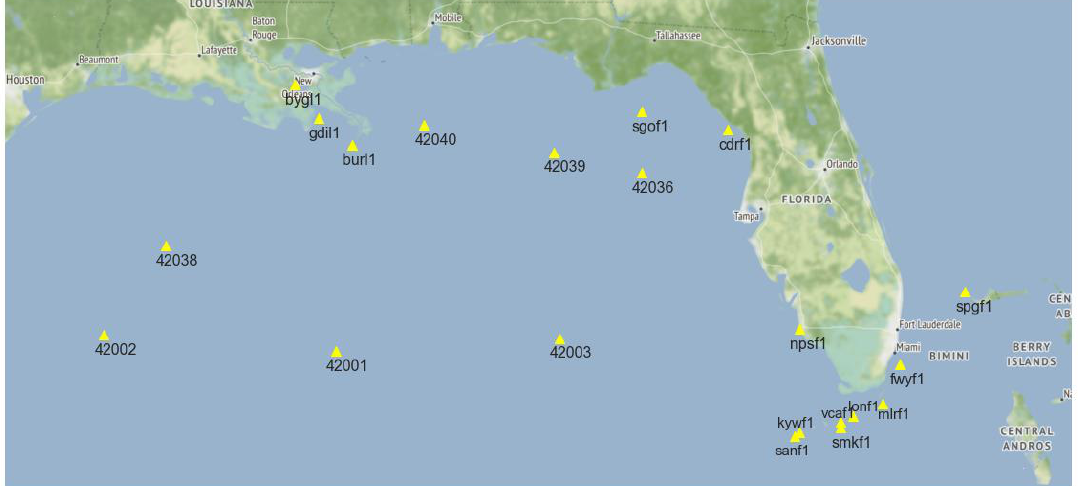
Figure 5. The location of buoys used in the experiment.